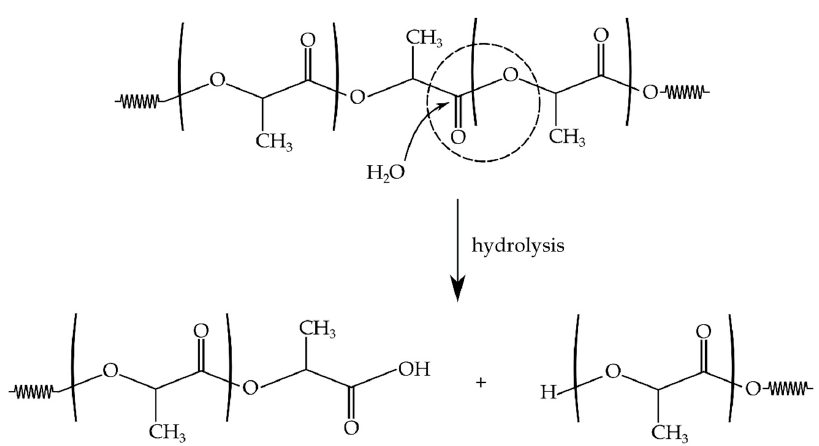
Figure 2. Schematic representation of the hydrolysis fragmentation of ester groups of polylactide (PLA) chains in the presence of water.